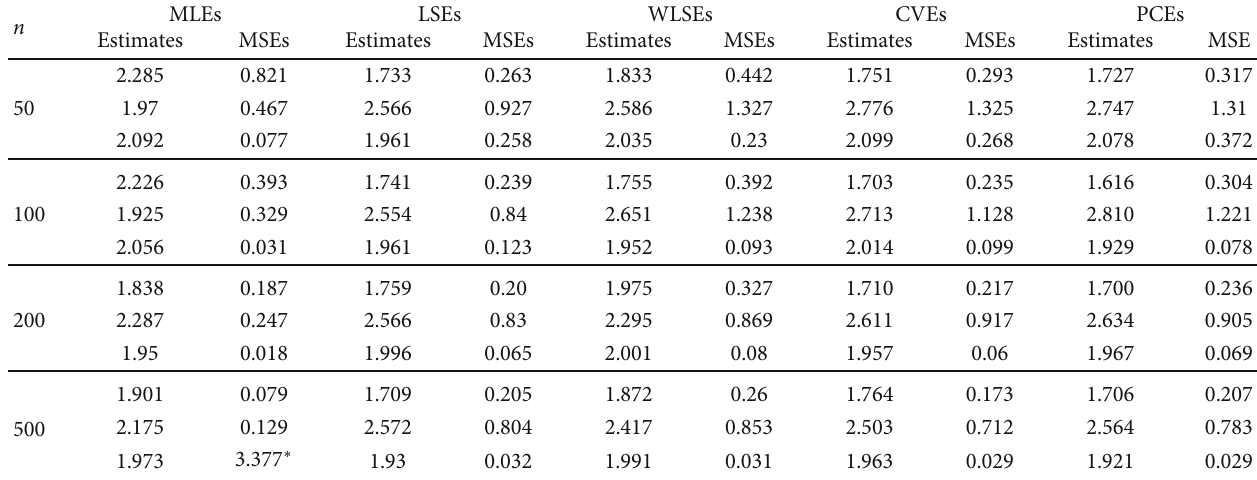
Table 2: Estimates and MSEs of parameters of TIIHLKw Distribution for the Set1 ( a = 2, λ = 2, b = 2 ).